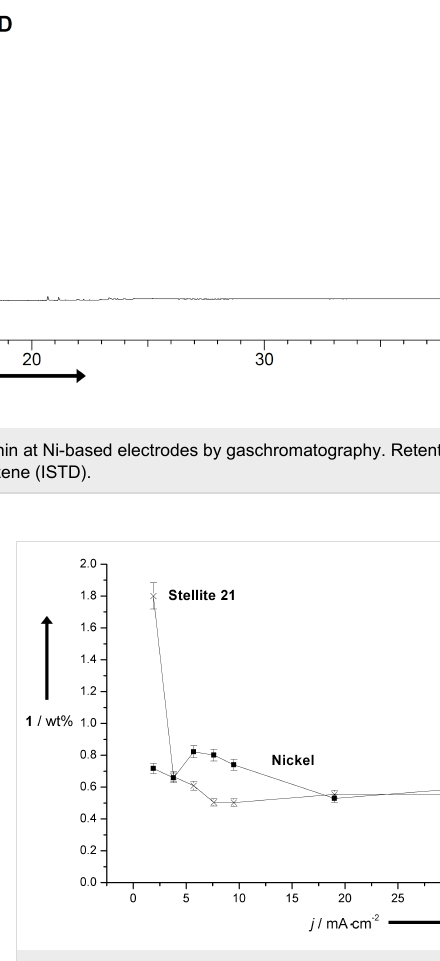
Figure 2: Influence of the current density onto the yield of 1 using Ni or Stellite 21 anodes.